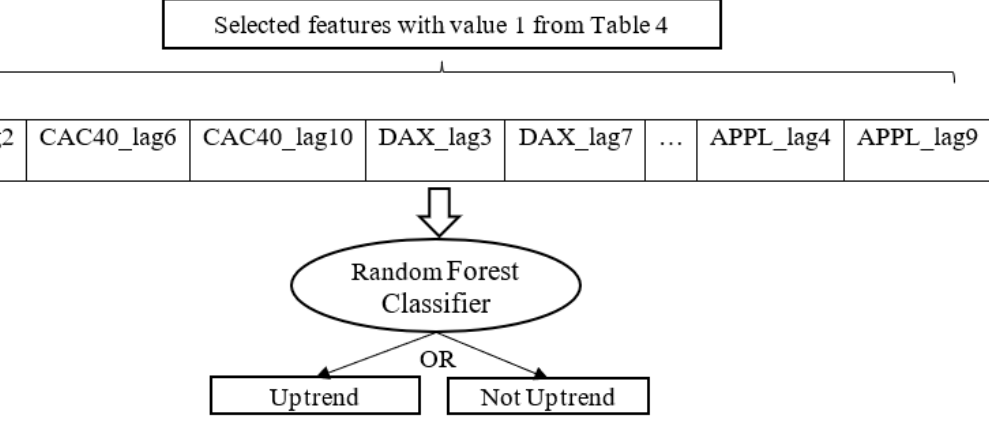
Figure 4. Random forest classifier.